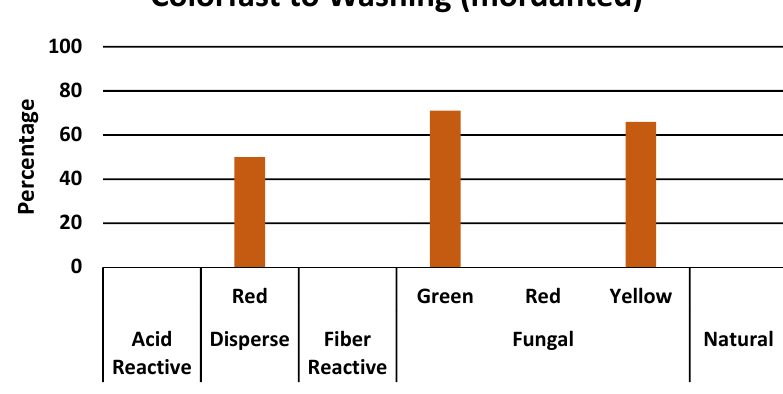
Figure 2. Results for colorfastness to washing, mordanted.